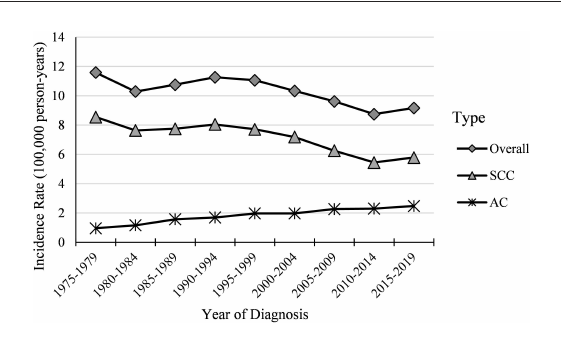
FIGURE1 Temporal trends in cervical cancer incidence rates (1975–2019) among females aged 20 to 44 years by histology, United States. All data are expressed as the rate per